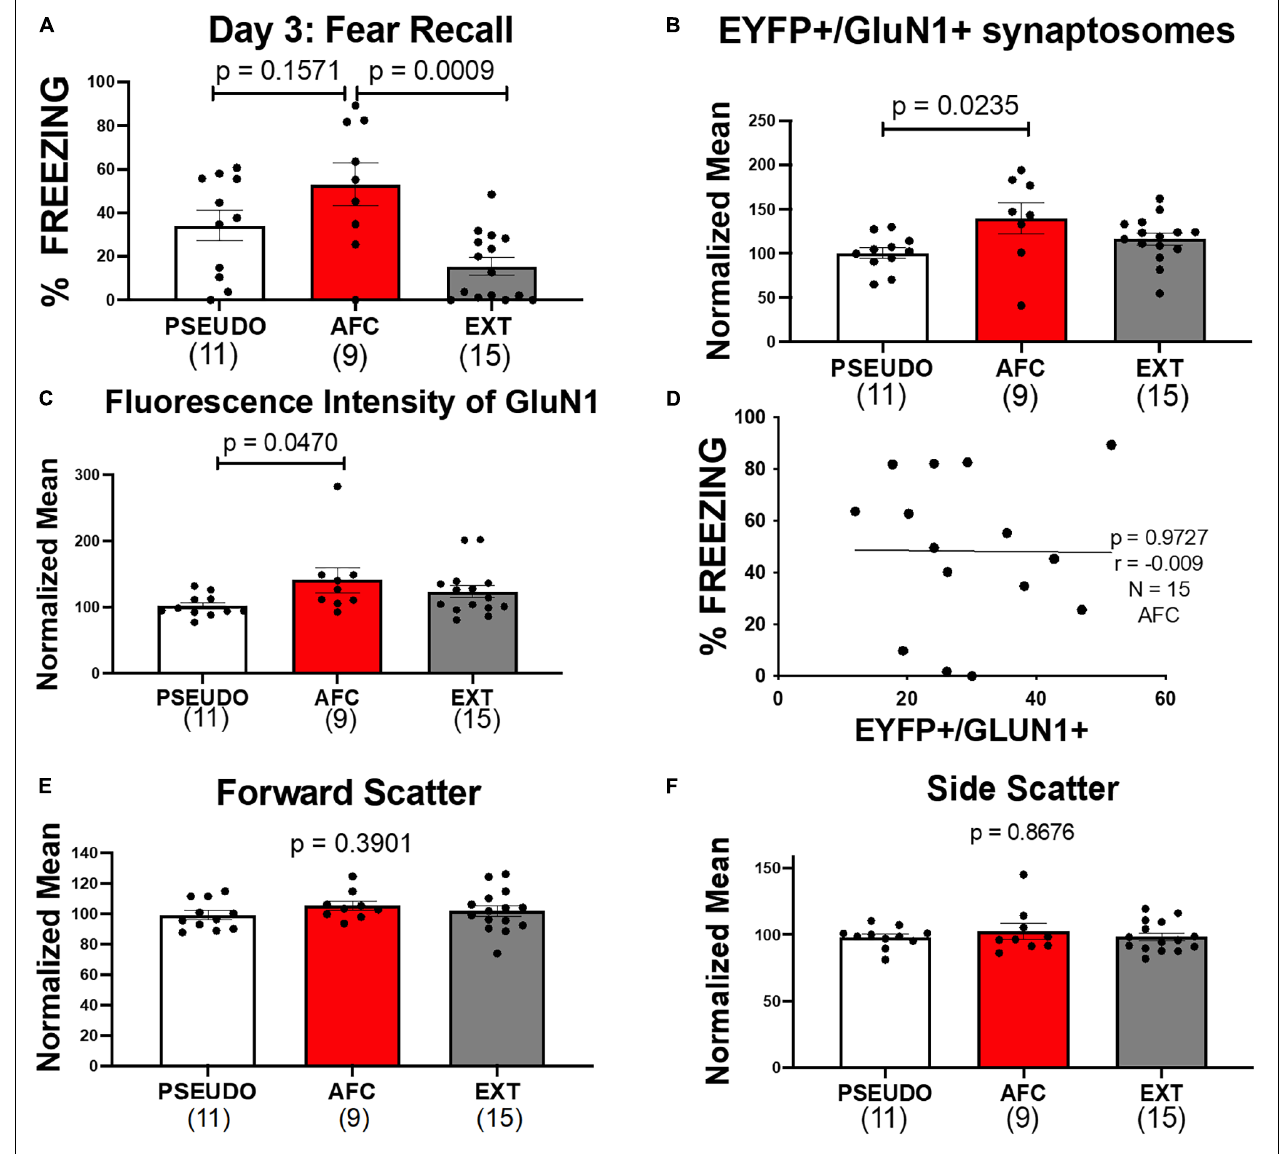
FIGURE 6 | Associative fear learning increases NMDARS on VHPC-to-IL synaptosomes in male rats. (A) Fear recall in the male groups. (B) Levels of EYFP+/GluN1+ synaptosomes normalized to the mean of the PSEUDO group of the corresponding age in the male groups. (C) Mean fluorescence intensity of GluN1 on EYFP+/GluN1+ synaptosomes in male groups normalized to the mean of the PSEUDO group of the corresponding age. (D) Graph comparing the levels of EYFP+/GluN1+ synaptosomes and the % freezing during recall of the males in the AFC groups in experiments 1 and 2. (E,F) Forward scatter and side scatter of EYFP+/GluN1+ synaptosomes in male groups normalized to the mean of the PSEUDO group of the corresponding